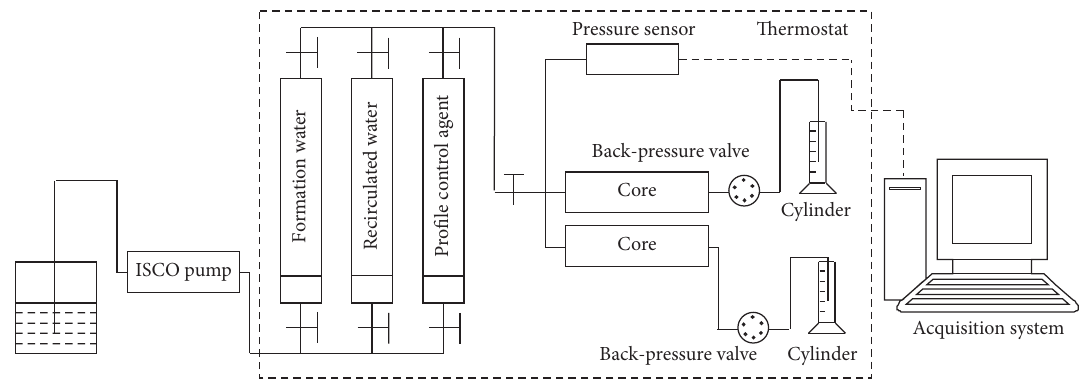
Figure 1: Flow chart of the parallel core plugging tests.